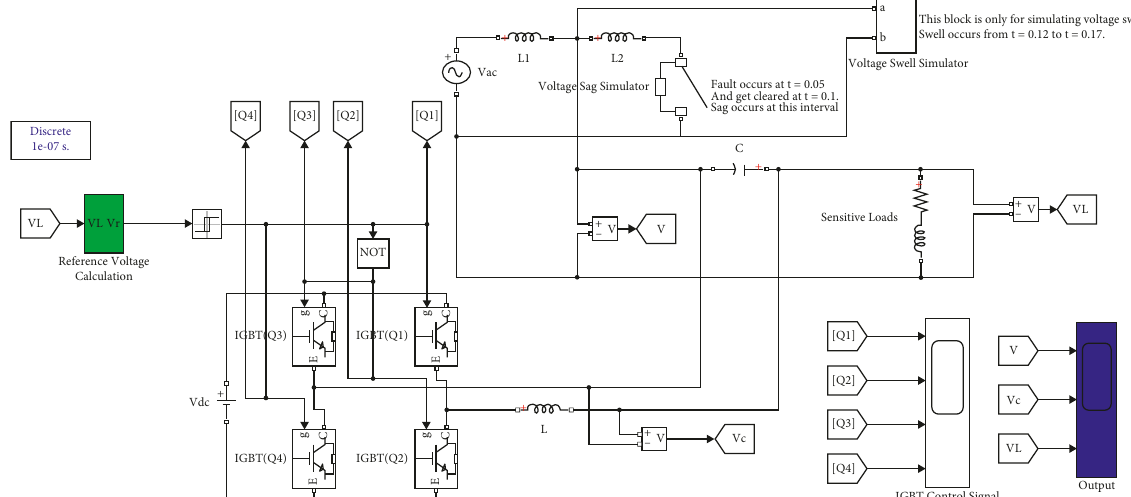
Figure 12: The presentation of simulation of the DVR system with virtual comparison voltage compensation strategy.